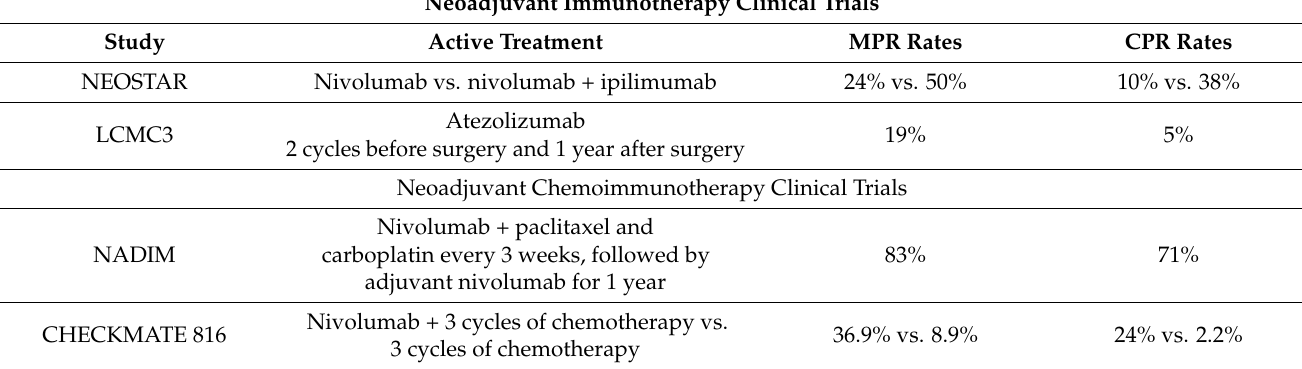
Table 1. Results of clinical trials with neoadjuvant therapy in terms of the percentage of patients who achieved MPR and